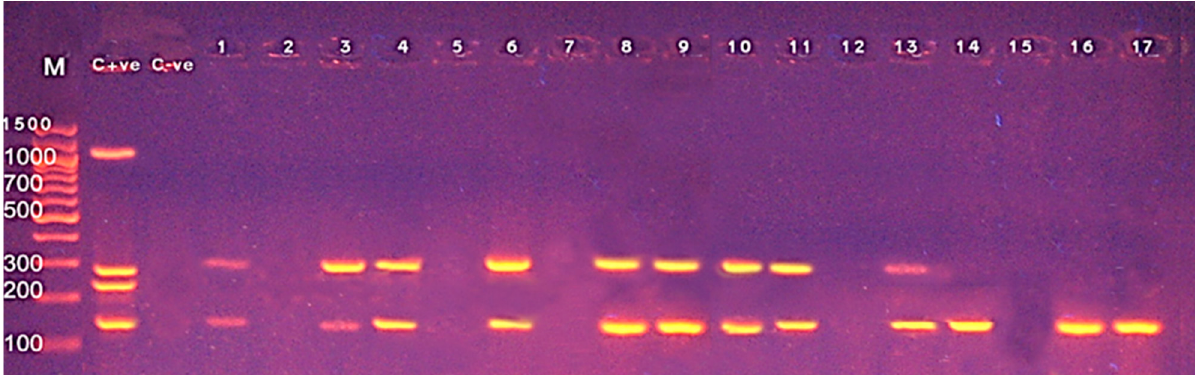
Figure 3. Amplification of inlA , actA , prfA and iap genes of L. monocytogenes at 255 bp, 268 bp, 1060 bp and 131 bp, respectively, by multiplex PCR. Lane M: 100 bp DNA ladder; Lane C +ve: Control Positive; Lane C -ve: Control Negative; Lane 1, 3, 4, 6 (minced meat), 8–11 (fish fillet), 13–14 (raw milk), 16–17 (sausage) were positive for the iap gene at 131 bp. While lane 1, 3, 4 (minced meat), 6, 8 (raw milk), 9, 10 (fish fillet) and 11, 13 (sausage) were positive for the actA gene at 268 bp. The prfA and inlA genes were not detected in any samples.